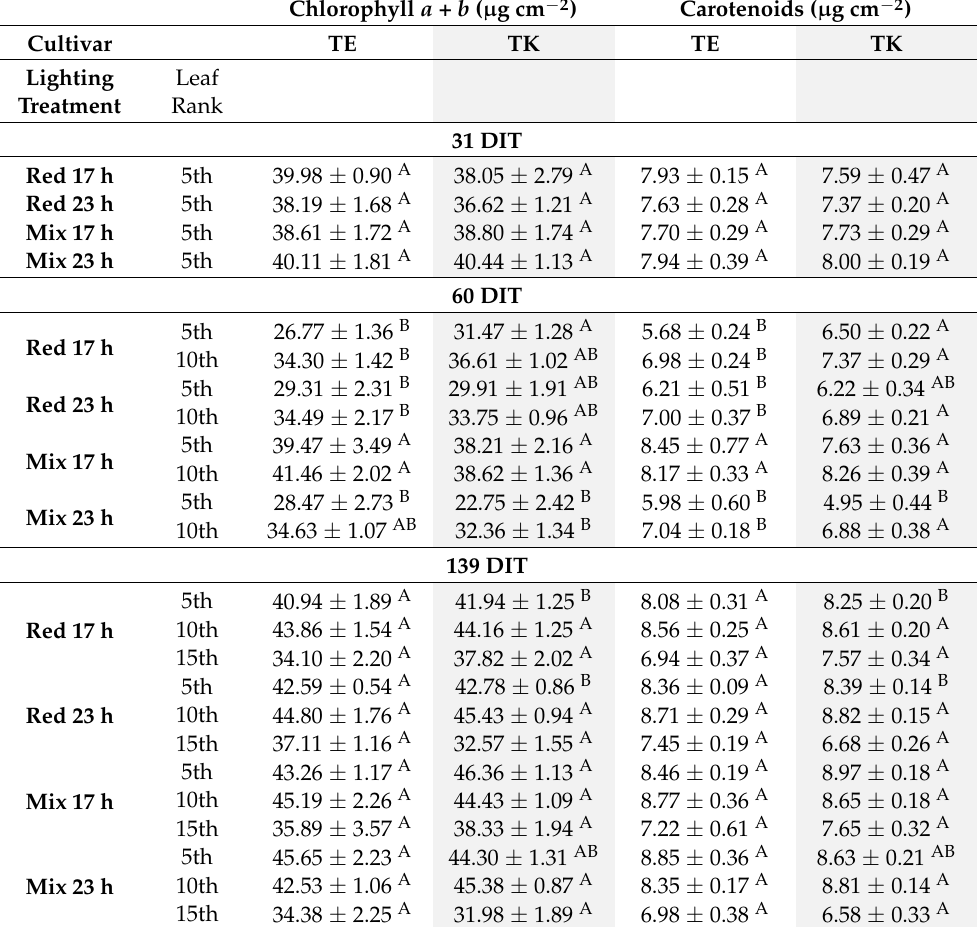
Table 5. Pigment analysis of plants grown under red 17 h, red 23 h, mix 17 h, and mix 23 h at 31 (16 December 2018), 60 (14 January 2019), and 139 DIT (3 April 2019). Values ± the standard error of the mean are representative of n = 6 for TE and TK plants under all lighting treatments. TE values are under white columns while TK values are under shaded columns. Different letter groups (A, B) represent a statistical difference between lighting treatments within a cultivar, time point, leaf rank, and pigment at p <